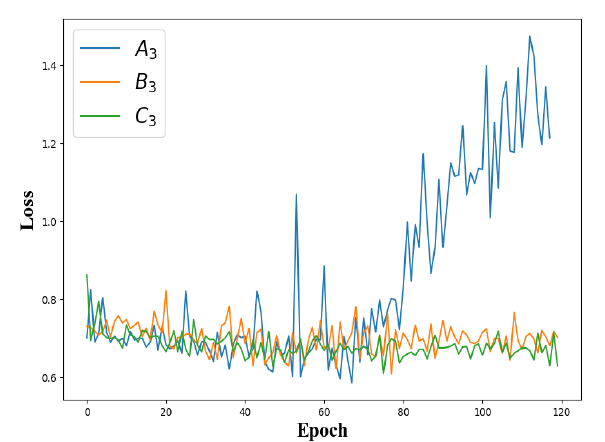
Figure 6. The validation loss of the A 3 , B 3 , and C 3 networks. We do not employ the dense connection or extra activation layer during the separated convolution in the B 3 and C 3 network. In this experiment, we set the batch size to one to highlight the effect of the 3D-DSC